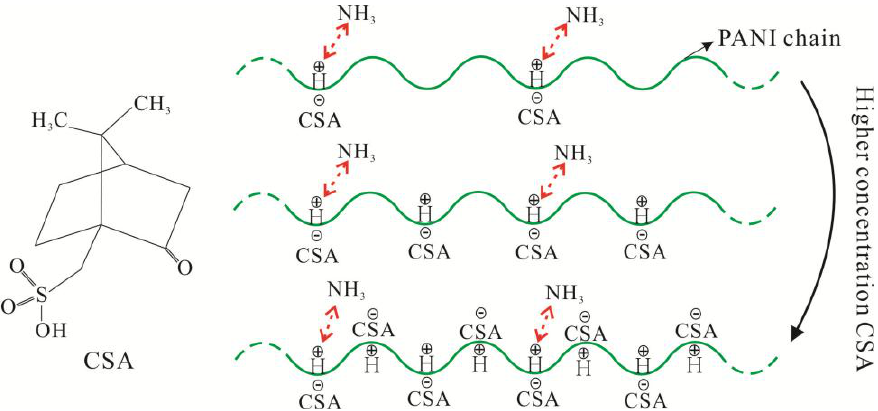
Figure 12. Schematic sensing mechanism of CSA-doped PA6/PANI composite